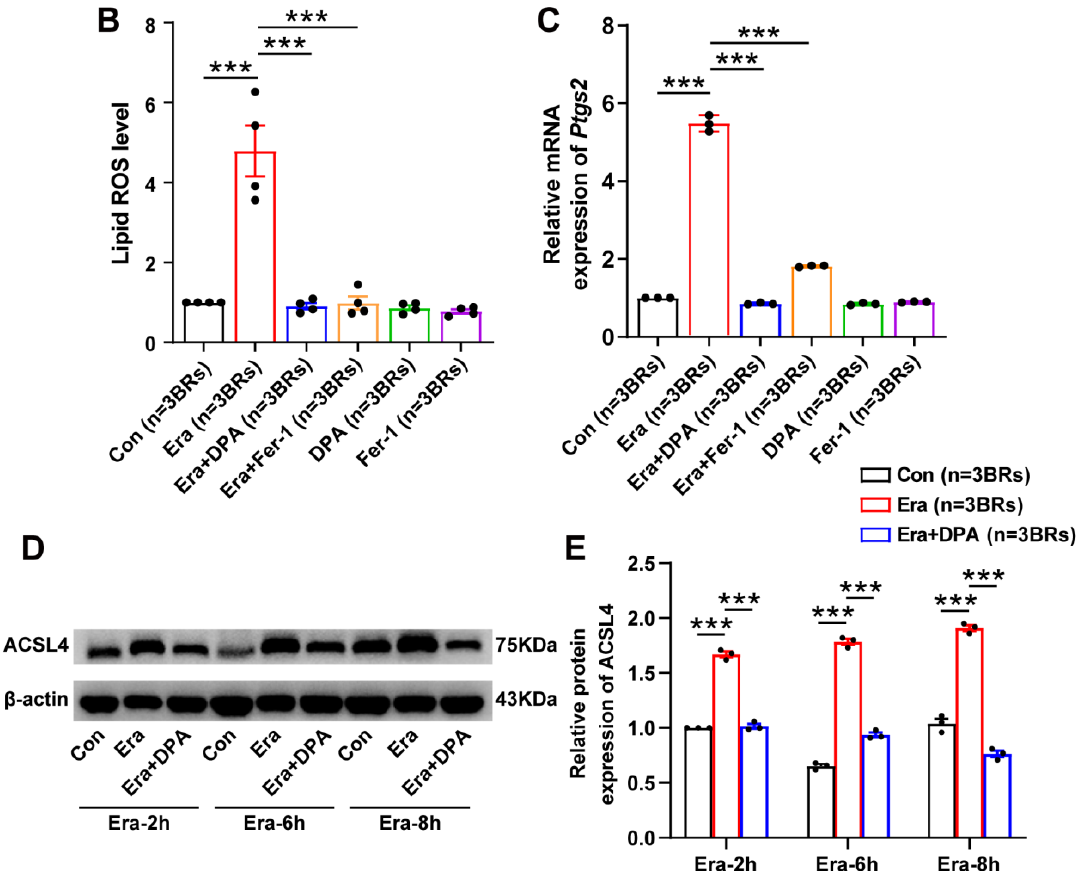
Figure 4. The anti-ferroptosis effect of DPA is validated in erastin-induced neuronal ferroptosis in vitro. ( A ) Representative phase contrast images indicating the effects of DPA by different concentrations (5, 10, 20, 40 and 80 µ g/mL) on neuronal ferroptosis induced by erastin (0.5 µ mol/L) for 8 h in HT22 cells. DPA was incubated 2 h prior to erastin challenge for 8 h in HT22 cells. DPA at the concentration of 20 µ g/mL exerted the most obvious protection against ferroptotic cell death in HT22 following erastin exposure. Thus, this concentration was utilized for the subsequent experiments. Arrows indicate the dead neurons. Scale bar indicates 50 μ m. ( B – E ) The effects of DPA on ferroptosis-associated indices including lipid ROS, Ptgs2 mRNA and protein expression levels of ACSL4 in erastin-induced ferroptosis in HT22 neuronal cells. The concentrations of DPA and Fer-1 (a specific ferroptosis inhibitor) in HT22 cells were 20 μ g/mL and 12.5 μ mol/L, respectively. In terms of the detections of lipid ROS and Ptgs2 mRNA, HT22 cells were treated with DPA or Fer-1 2 h prior to erastin treatment for 8 h while the cell samples used for detecting ACSL4 protein expression were collected following pretreatment with DPA for 2 h and erastin exposure at different time points (2 h, 6 h and 8 h). All the data were expressed as mean ± SEM ( n = 3 independent biological replicates). *** p < 0.001. Abbreviation: Era, erastin; DPA, D-penicillamine; Fer-1, ferrostatin-1; Ptgs2 , prostaglandin-endoperoxide synthase 2; lipid ROS, lipid reactive oxygen species; ACSL4, acyl-coA synthetase long chain family member 4; BRs, biological